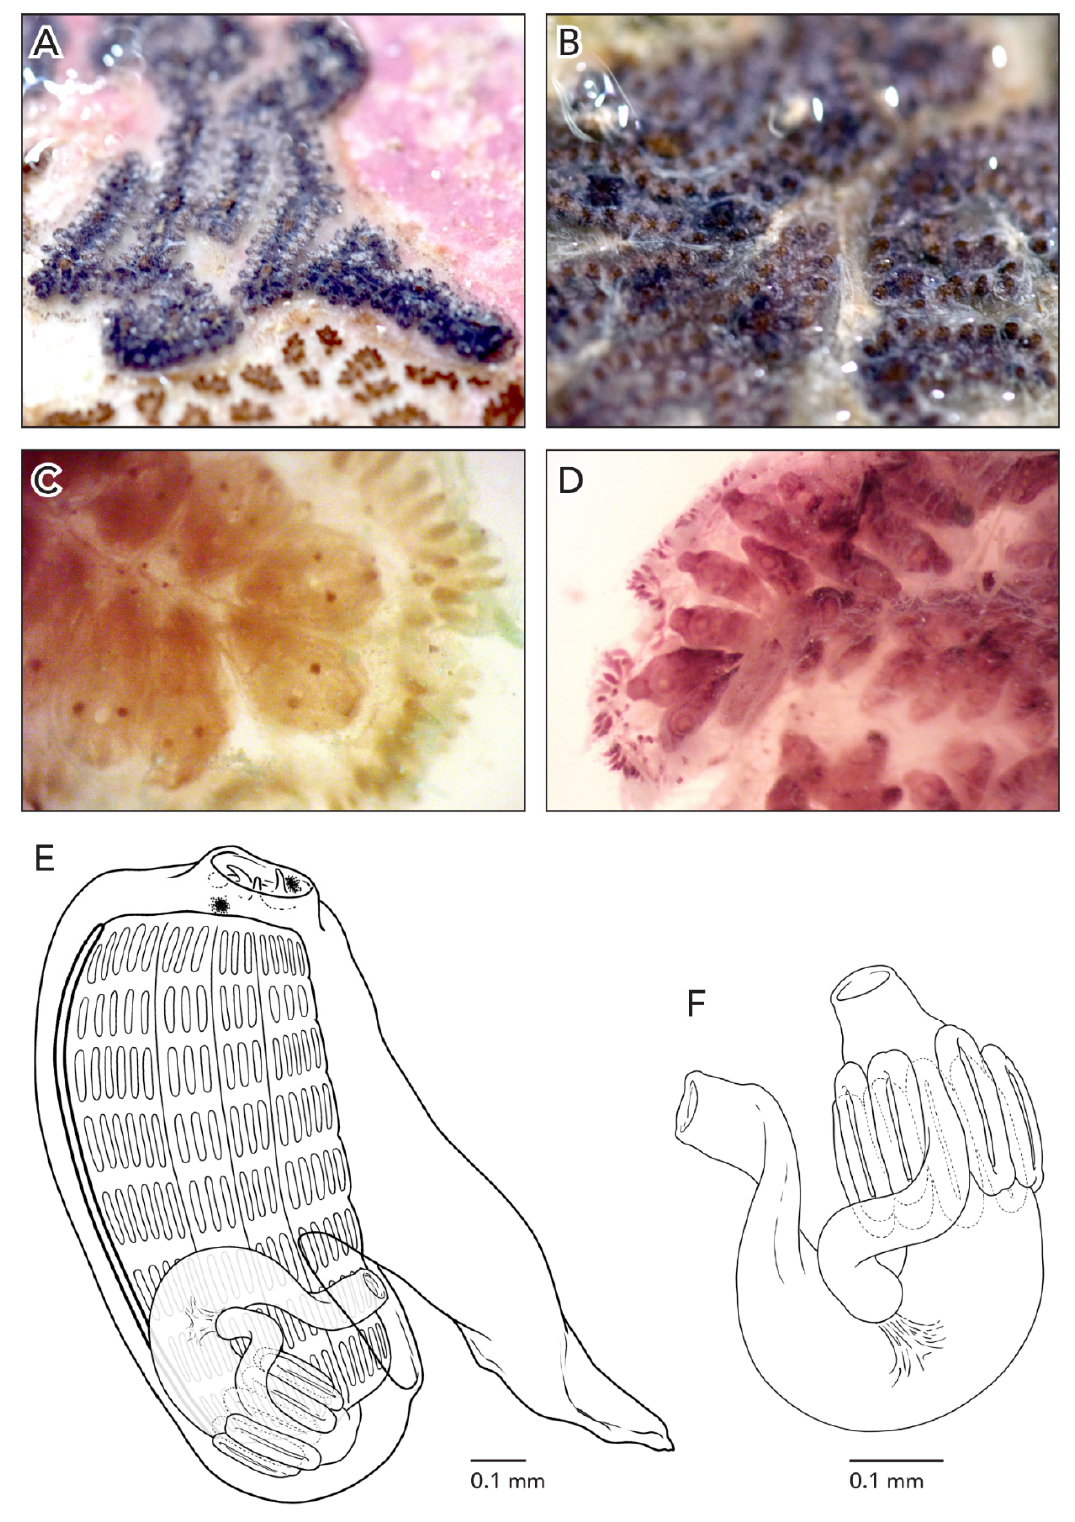
Figure 6. Botryllus humilis Monniot, 1988. ( A , B ) Live colonies on artificial substrate (PVC) ( C ) Preserved zooids showing the two spots of dark pigment present in the anterior area ( D ) Preserved colony with zooids and ampullae in the margin ( D ) Left side view of a zooid ( E ) Detail of abdomen region ( F ). Detail of the abdomen region.